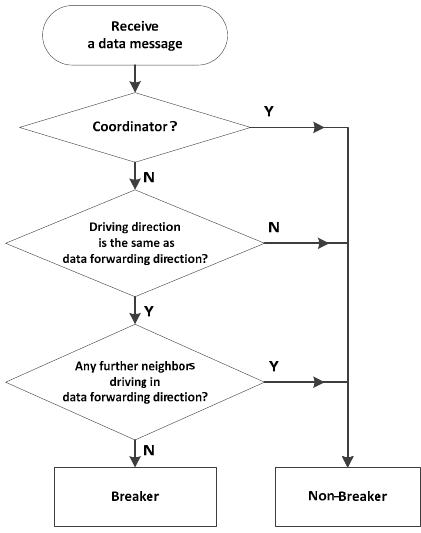
Figure 5. The identification of a breaker flowchart.